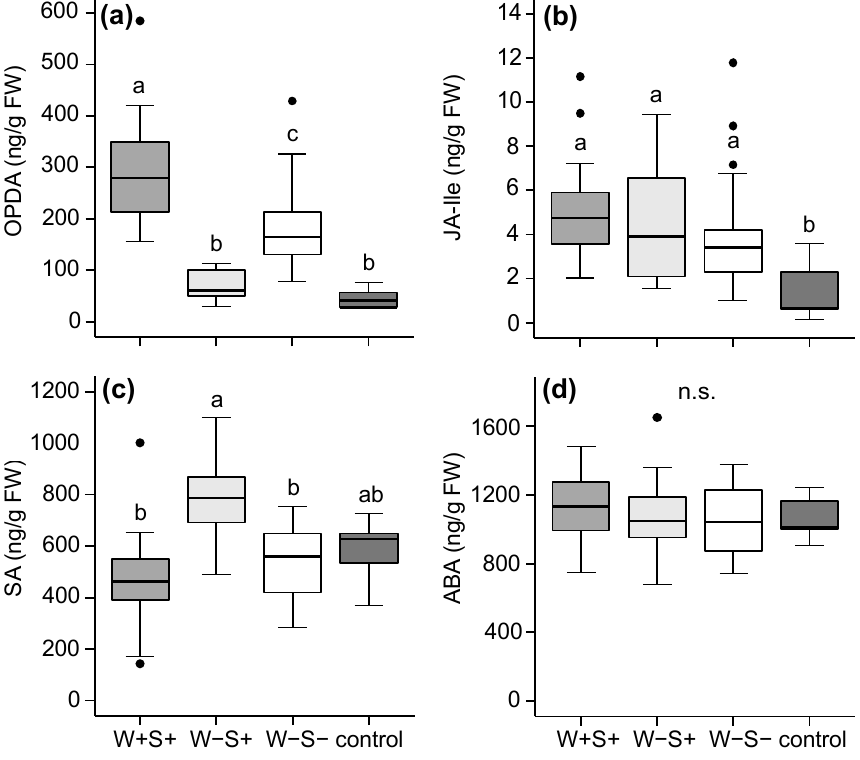
Figure 3. Phytohormone amounts in tomato ( S. lycopersicum ) leaflets after seven days of infestation with the spider mite T. urticae DeLier-1 strain which did (+) or did not ( − ) contain the bacteria Wolbachia (W) and Spiroplasma (S). Control plants were not infested. Phytohormones for which we assayed include ( a ) 12-oxo-phytodienoic acid (OPDA); ( b ) jasmonic acid-isoleucine (JA-Ile); ( c ) salicylic acid (SA); and ( d ) abscisic acid (ABA). Boxes span the 25–75 percentiles, horizontal lines in the boxes represent medians, whiskers span 1.5× IQR, dots represent data points outside this range. Different letters above the boxes indicate significant differences at a level of p ≤ 0.05, after applying linear mixed models followed by Tukey multiple comparisons with Holm adjustment. Phytohormone amounts are presented as nanogram per gram fresh leaf weight (ng·g − 1 ·FW). n.s.: not significant.